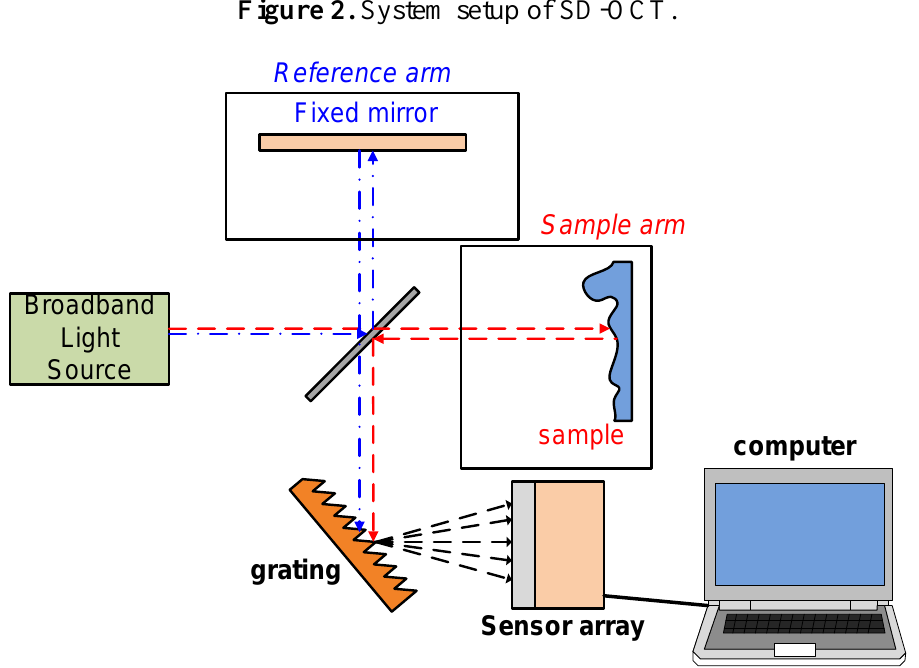
Figure 2. System setup of